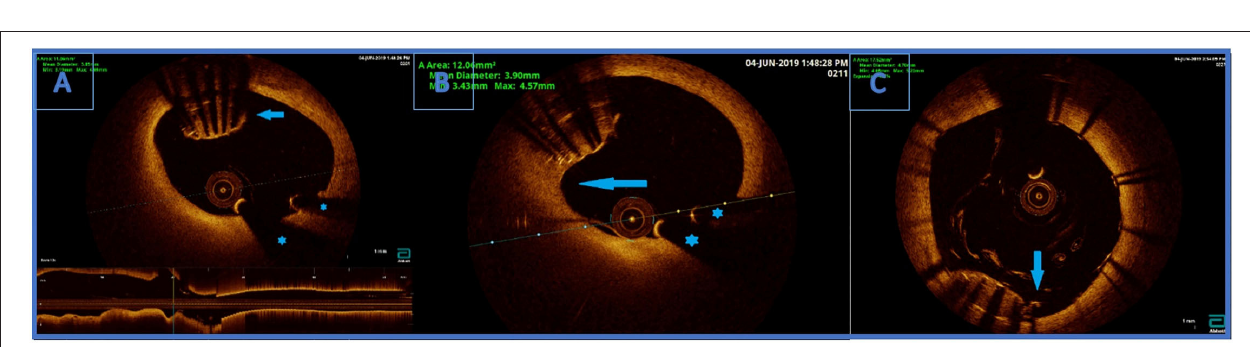
FIGURE 2 | (A) Second coronary angiography revealed newly formed, highly significant ostial (95%) (Medina 0.0.1) LCx stenosis. Also, previously known distal LCx stenosis (90%) was shown. (B) The end of the second intervention (angiography without iodinated contrast): the lost stent in the left main coronary artery (arrow). The distal part of the lost stent (part in the LCx, 70% of its length) is crushed with the proximal LCx stent. (C) The end of the second intervention where proximal and distal LCx stenosis were solved (arrows indicating lesion sites where the stents were implanted).